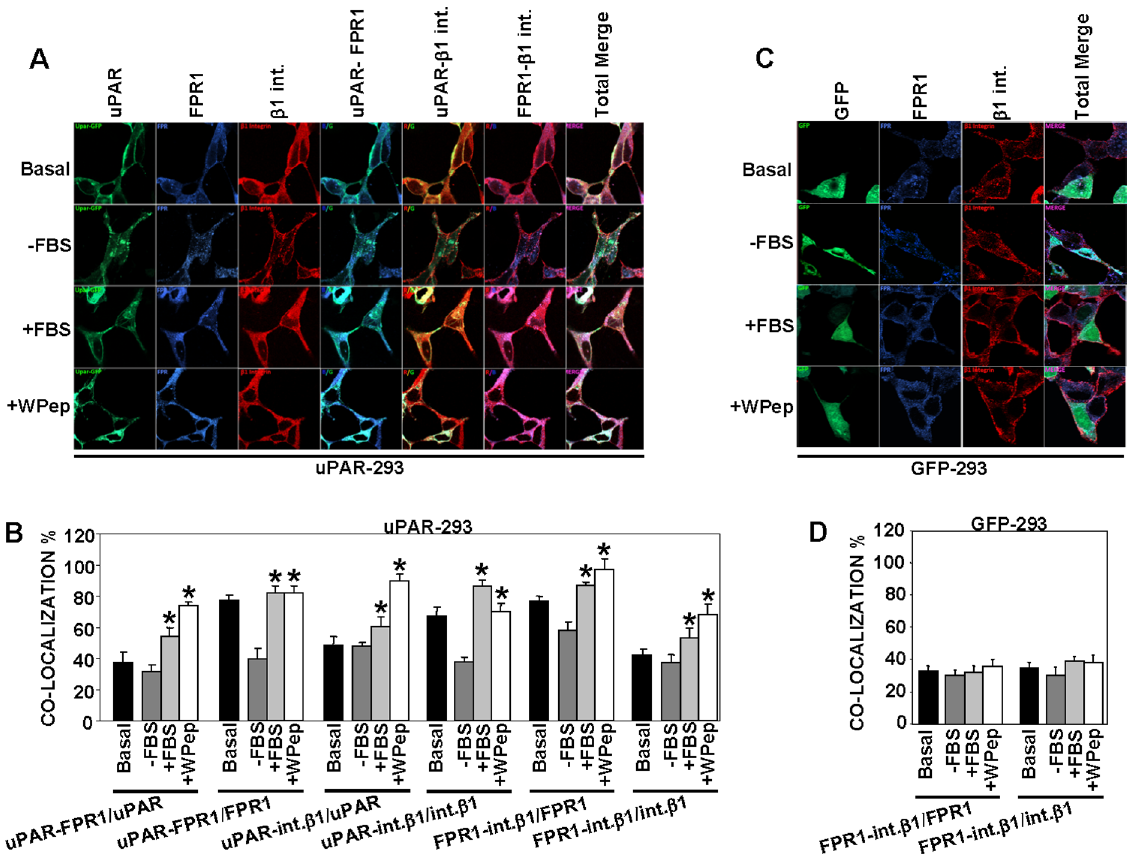
Figure 2. uPAR recruits fMLF receptors and integrins on the cell membrane. A: HEK-293 cells were seeded on glass coverslips and transiently transfected with EGFP-uPAR cDNA; after 24 h, cells were incubated for further 24 h in DMEM containing 10% serum (Basal) or in DMEM without serum ( 2 FBS). Prior to fixation, some serum-starved samples were stimulated for 1 h at 37 u C, 5% CO2, with 10% FBS in DMEM ( + FBS) or with 5 nM WKYMVm peptide ( + W Pep) in DMEM. All samples were then fixed, incubated with the anti-FPR1 polyclonal antibody and with the mouse anti- b 1 monoclonal antibody, stained with Cy5 or Alexa 594 conjugated secondary antibodies, and analyzed by confocal microscopy. B: The degree of co- localization of the fluorescent signals in panel A was quantified on a minimum of 50 different cells by using the LSM 510 software. The number of